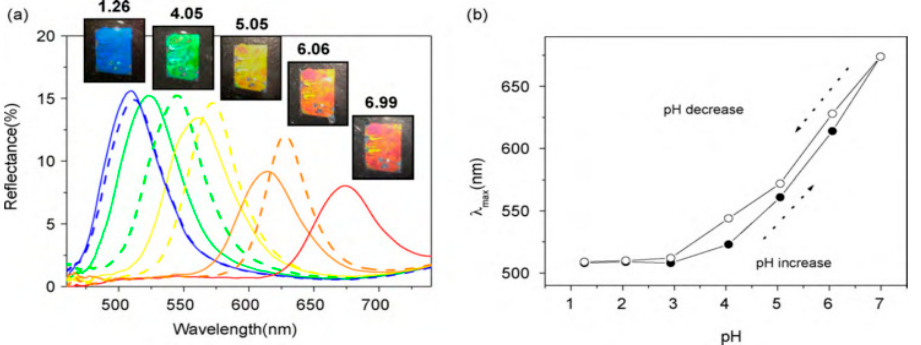
Figure 21. ( a ) pH-dependent color change and respective reflectance spectra of hydrogel pH sensors between pH of 1.26 and 6.99. A series of spectra were measured during pH increase (solid curves) and during pH decrease (dashed curves). ( b ) Plot of λ max change during pH increase and decrease showing a weak hysteresis [152].